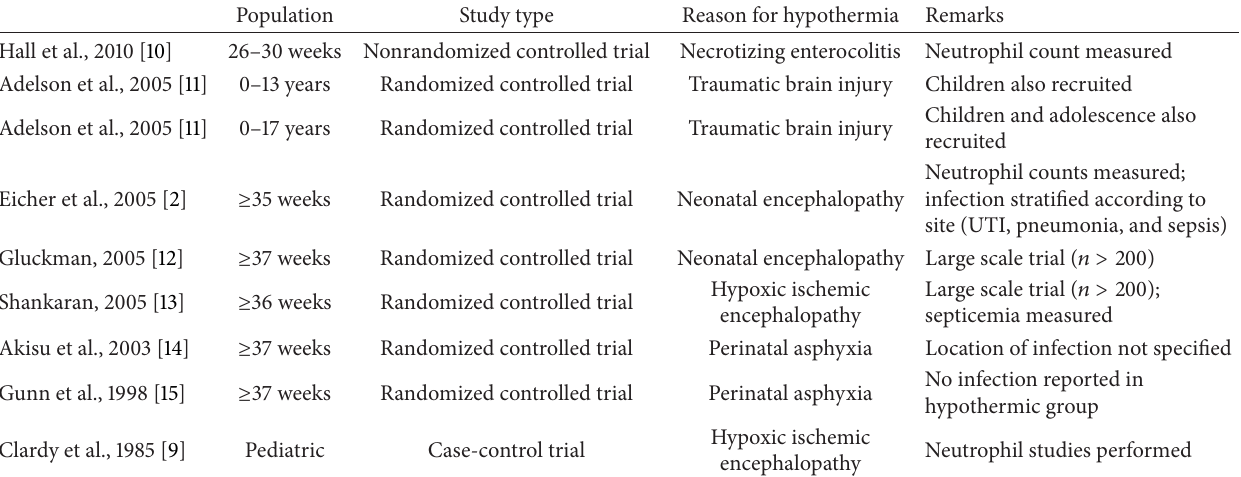
Table 1: Publications of therapeutic hypothermia reviewed.